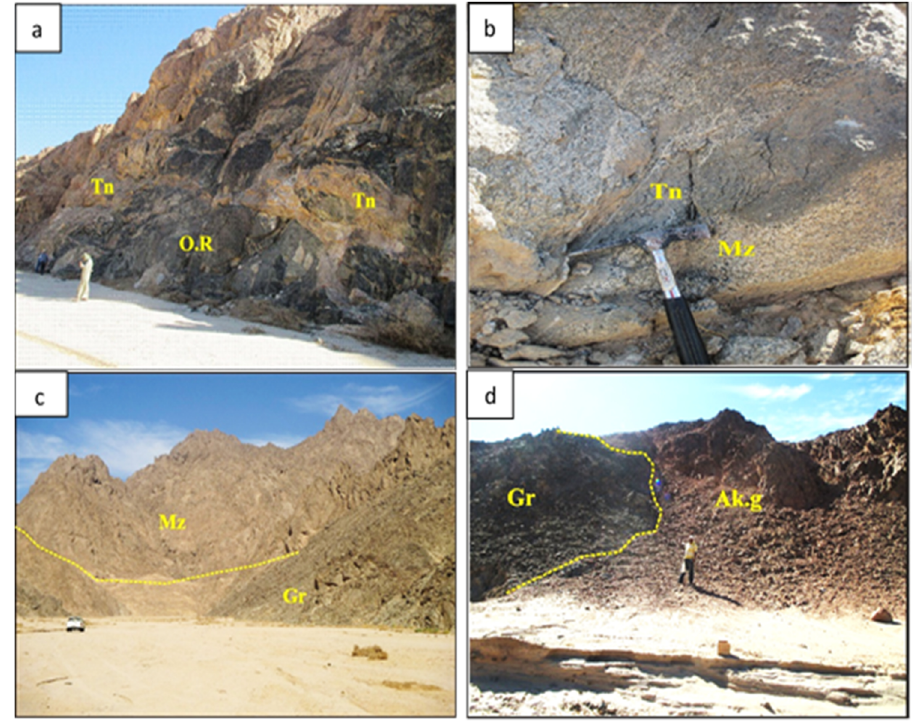
Figure 3: Photograph showing ( a ) Tonalitic rock ( Tn ) intruded in oldest rock ( OR ) at Gable Abu Furad ( b ) Monzogranite ( Mz ) contains on xenoliths from tonalitic rocks ( Tn ) at Wadi Um Taghir, ( c ) sharp contact between granodiorite ( Gr ) and monzogranite ( Mz ) at Gable Abu Hawiesand ( d ) sharp contact between granodiorite ( Gr ) and alkali - feldspar granite at Gable Abu